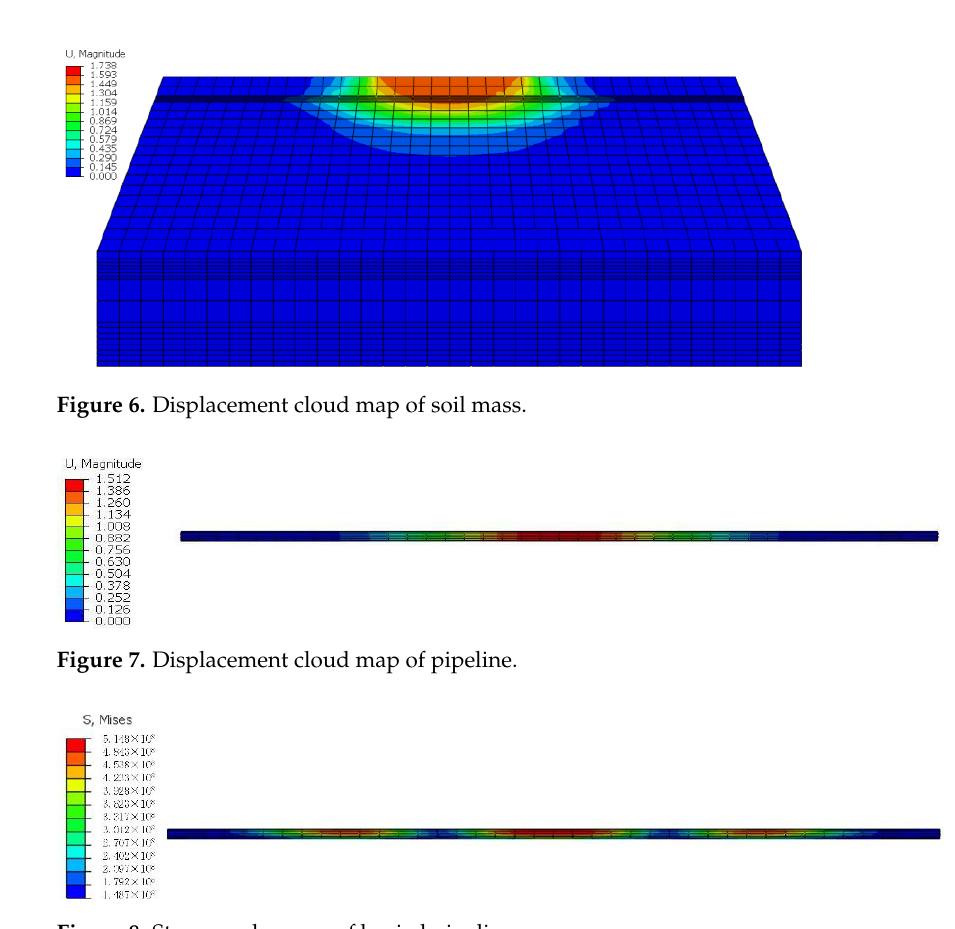
Figure 8. Stress nephogram of buried pipeline.